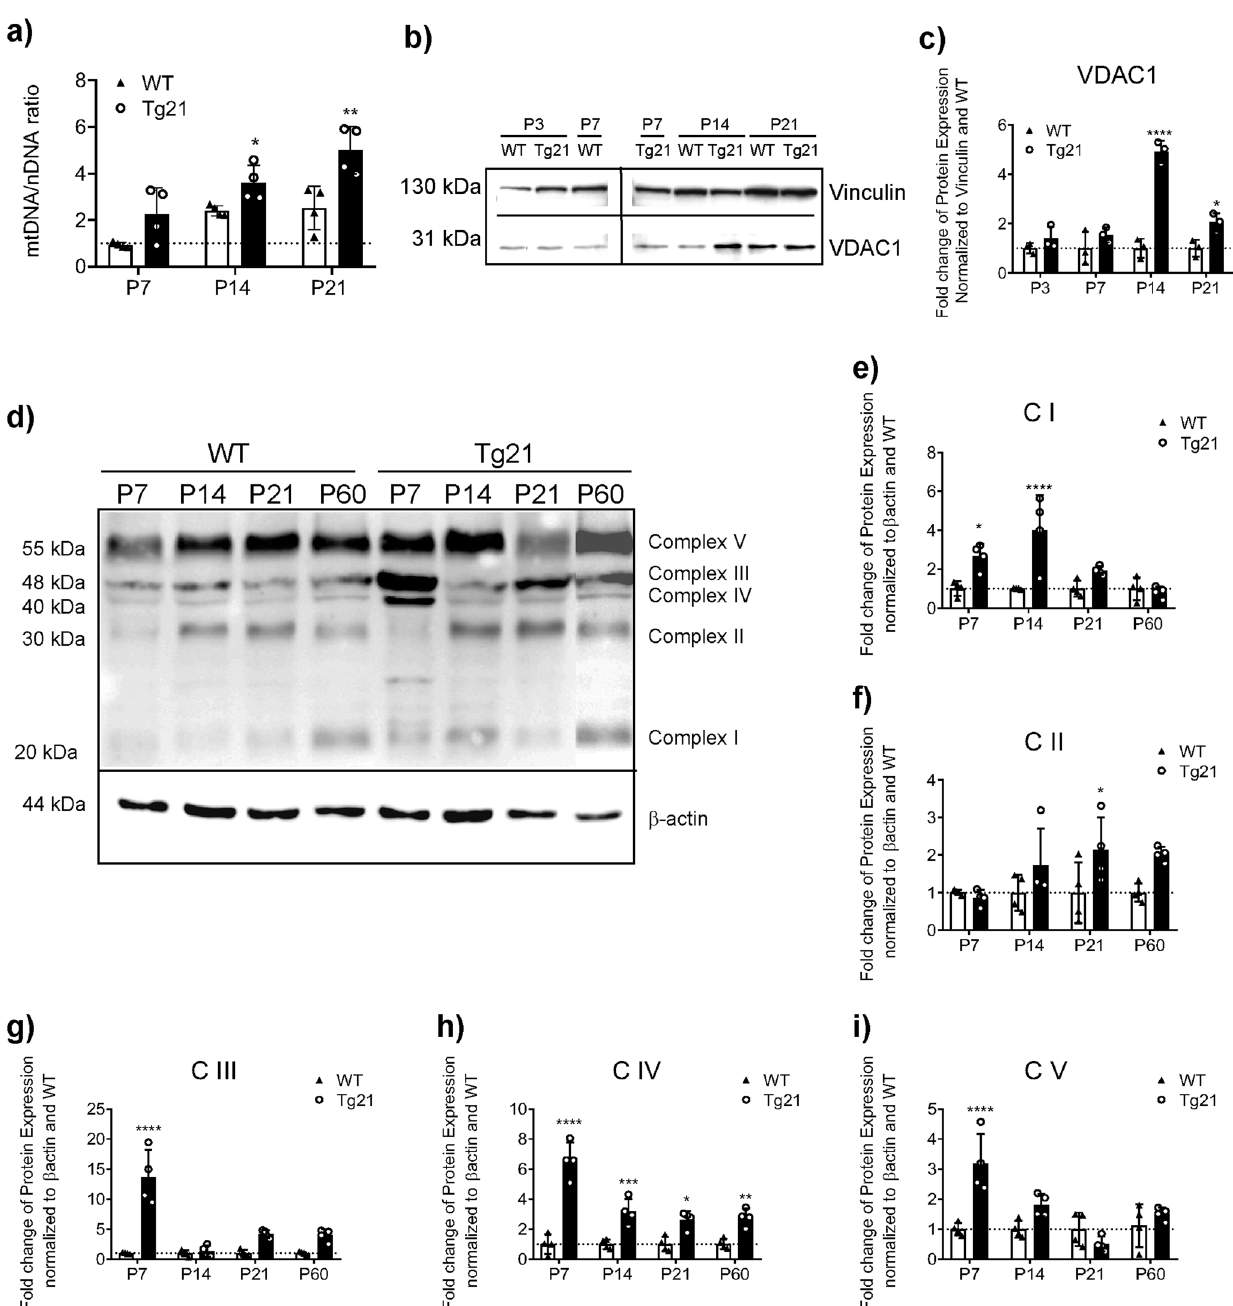
Fig. 4 EPO overexpression in the CNS increases mitochondrial DNA, voltage-dependent anion channel 1 (VDAC1), and electron transport system proteins in the hippocampus throughout postnatal development. a Fold change in mitochondrial (mt) DNA over nuclear (n) DNA ratio in WT and Tg21 mice across postnatal ages P: 7, 14, and 21 shows higher mtDNA to nDNA in Tg21 mice; 2-way ANOVA, F (1,18) = 26.19, **** p < 0.0001, with multiple comparisons: * p < 0.05 and ** p < 0.01. b Representative images of total VDAC1 with vinculin as a loading control across postnatal ages P: 3, 7, 14, and 21. c Quanti fi cation of VDAC1 protein expression normalized to vinculin and to WT at P3; 2-way ANOVA, F (1,16) = 73.94, **** p < 0.0001. d Representative uncropped images of mitochondrial electron transport system protein expression and against β -actin as loading control in WT and Tg21 mice across postnatal ages P: 7, 14, 21, and 60. e Quanti fi cation of protein expression for mitochondrial complex I (CI), NADH dehydrogenase subunit NDUFB8; 2-way ANOVA, F (1,24) = 26.69, **** p < 0.0001; f mitochondrial complex II (CII), succinate dehydrogenase complex iron-sulfur subunit B (SDHB); 2-way ANOVA, F (1,24) = 10.93, **p = 0.003; g mitochondrial complex III (CIII), ubiquinol – cytochrome c reductase core protein 2 (UQCRC2); 2-way ANOVA, F (1,24) = 62.26,**** p < 0.0001; h mitochondrial complex IV (CIV), cytochrome c oxidase (COX), subunit 1; 2-way ANOVA, F (1,24) = 131.9, **** p < 0.0001; and i mitochondrial complex V (CV), ATP synthase alpha subunit (ATP5A); 2-way ANOVA, F (1,24) = 15.24, *** p = 0.0007. Mitochondrial protein expression is higher in Tg21 mice at P7 (CIII, CIV, and CV), P14 (VDAC1, CI, and CIV), P21 (VDAC1, CII, and CIV), and P60 (CIV). Dotted lines represent values of 1. Multiple comparisons: 2-way ANOVA: * p < 0.05, ** p < 0.01, *** p < 0.001, and **** p < 0.0001. Barplots with SD